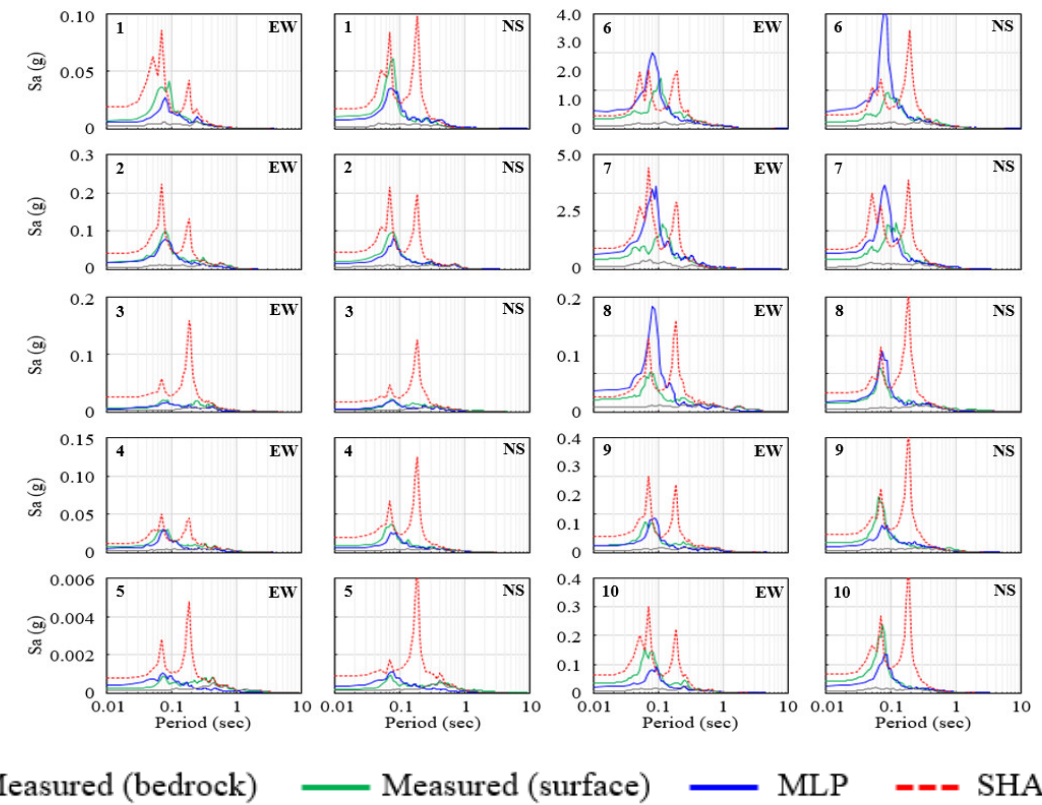
Figure 12. Measured, predicted, and computed response spectra at IWTH23 for east–west and north–south directions.